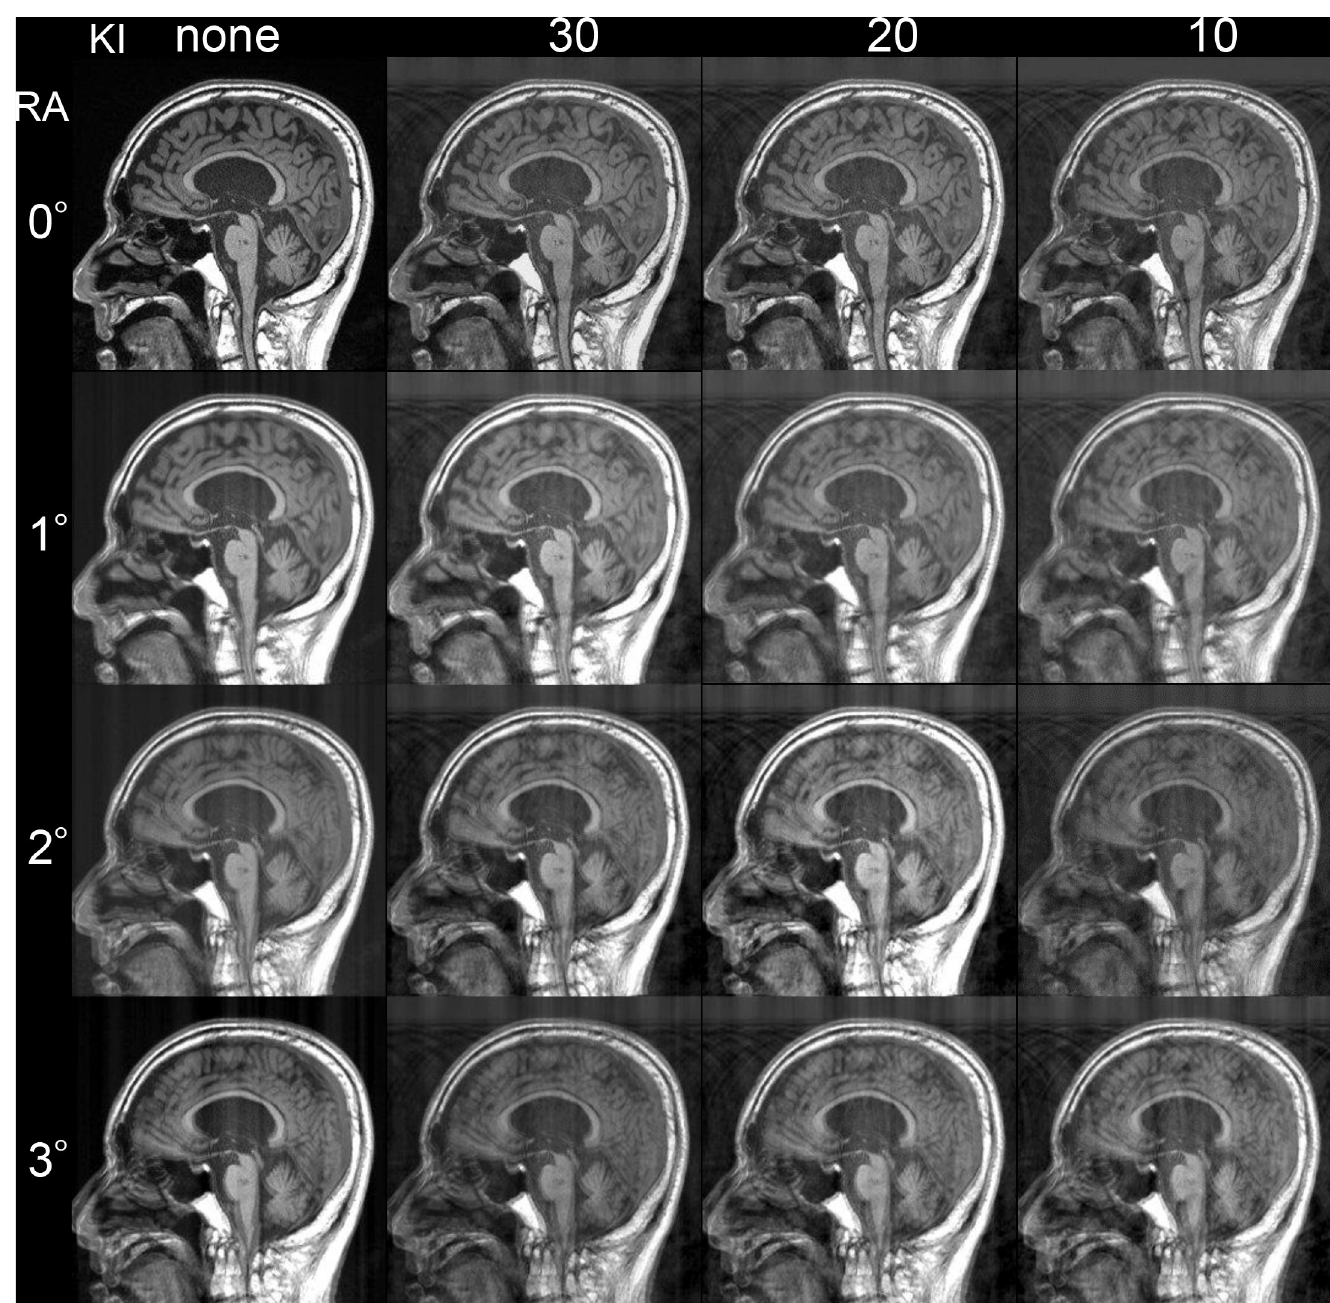
Fig 3. Training data sets. A total of 16 artifact images were created with four rotation angles (RA) and four patterns of k-space zero-fill intervals (KI). In the artifact images, the larger the rotation angle, or the smaller the zero-fill interval in k-space, the stronger the motion artifact. In the present study, we created a training data set by pairing each of the 16 artifact images with the original image. We demonstrate an example used as the input image for the training